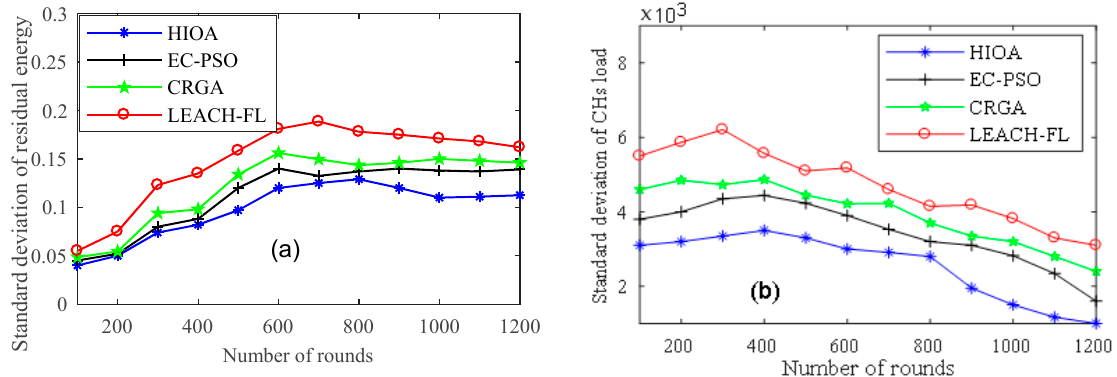
Figure 9. Standard deviation over rounds: ( a ) residual energy and ( b ) CH load.